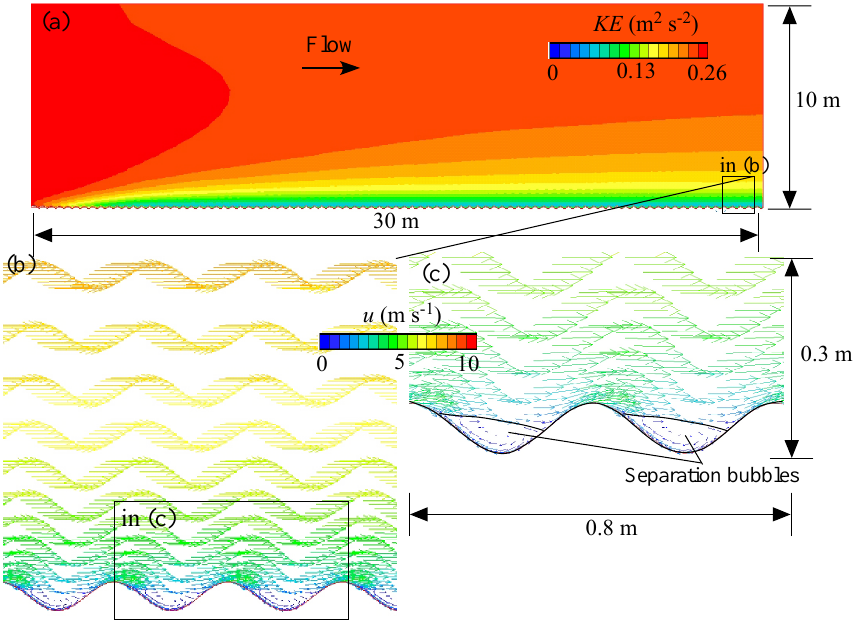
Figure 10. Illustrations of the output of the PHOENICS CFD model for the example case (with amplitude a = 0 . 05m and maximum slope S = 0 . 79m/m) of flow over a sinusoidal bed. (a) Color map of turbulent kinetic energy, KE. This map illustrates the growth of the internal boundary layer triggered by the effective roughness change as the input velocity profile (characterized by a grain-scale roughness z 0g ) interacts with and adjusts to the microtopography. The color vector maps in (b) and (c) illustrate the zones of flow recirculation that occur in the lee side of each bedform.